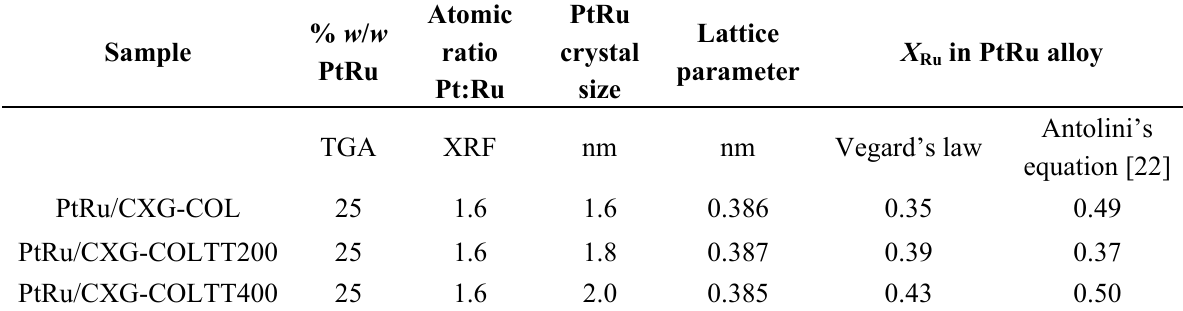
Table 2. PtRu crystal size obtained by XRD and PtRu concentration in the synthesized catalysts.